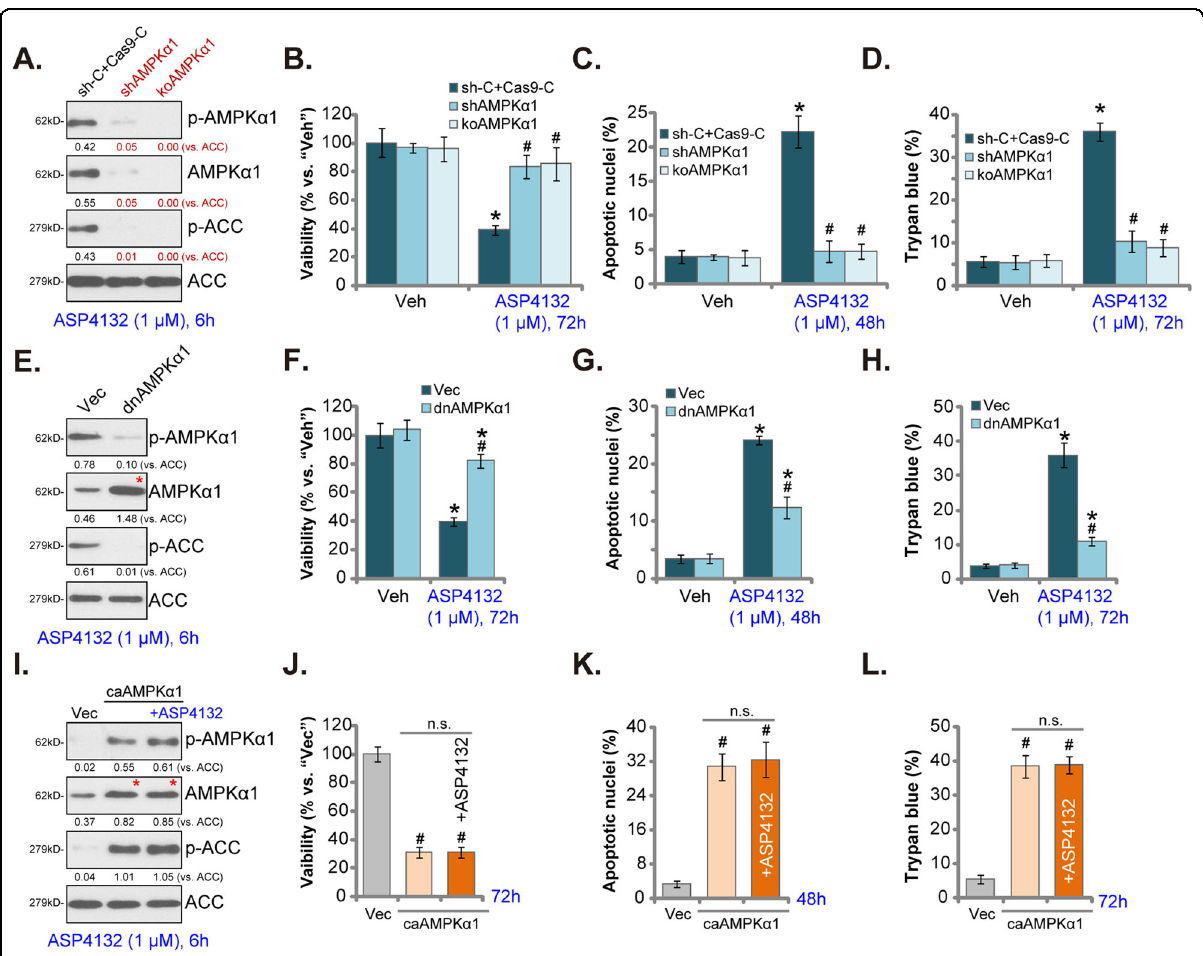
Fig. 5 AMPK activation mediates ASP4132-induced anti-NSCLC cell activity. Stable pNSCLC-1 cells, expressing the lentiviral AMPK α 1 shRNA ( “ shAMPK α 1 ” ), the CRISPR/Cas9-AMPK α 1-KO construct ( “ koAMPK α 1 ” ) ( A – D ), the dominate negative AMPK α 1 (T172A, “ dnAMPK α 1 ” ) ( E – H ), the constitutively active AMPK α 1 (T172D, caAMPK α 1) construct ( I – L ), or corresponding control shRNA or empty construct, were established; Cells were treated with ASP4132 (1 μ M) or vehicle control and cultured for applied time periods, expression of listed proteins was tested by Western blotting assays ( A , E , I ). Cell viability, apoptosis and death were tested by CCK-8 ( B , F , J ), apoptotic nuclei staining ( C , G , K ) and Trypan blue staining ( D , H , L ) assays, respectively. Expression of listed proteins was quanti fi ed and normalized to the loading control ( A , E , I ). Red stars indicated expression of the mutant AMPK α 1 ( E , I ). “ Veh ” stands for the vehicle control (Saline). Data were presented as mean ± standard deviation (SD, n = 5). “ sh-C + Cas9-C ” stands for control pNSCLC-1 cells with scramble control shRNA plus CRISPR/Cas9 empty vector ( A – D ). “ Vec ” stands for empty vector ( E – L ). * p < 0.05 vs. “ Veh ” cells. # p < 0.05 vs . ASP4132-treatment in “ sh-C + Cas9-C ” control cells or “ Vec ” control cells. “ n.s. ” stands for non-statistical difference. The experiments were repeated fi ve times with similar results